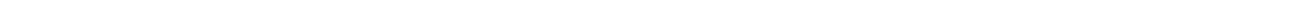
Fig. 2 Ssb is required for proper TORC1-dependent phosphorylation of Sch9-T737. a Cells lacking Ssb display rapamycin sensitivity. Serial dilutions of logarithmically growing cells were spotted onto YPD plates with or without 6 ng ml − 1 rapamycin and were incubated at 30 °C. b Sch9 is hypo- phosphorylated in the absence of Ssb. Protein extracts from glucose-grown Δ sch9 cells expressing Sch9-FLAG were analyzed on phos-tag gels as described in Fig. 1. S3 # indicates the faster migrating species detected in Δ ssb1 Δ ssb2 . c T570 phosphorylation is unaffected by Ssb. Total extracts of the strains indicated were resolved on Tris-Tricine gels and were subsequently analyzed via immunoblotting with α -T570-Pi, α -Sch9, and α -Sse1 (loading control). d Sch9 phosphorylation at T737 depends on Ssb. Protein extracts from Δ sch9 cells expressing Sch9-FLAG or Sch9-T737A-FLAG were analyzed on phos- tag gels as described in Fig. 1. S3 # indicates the faster migrating form of S3 seen in the absence of Ssb, which comigrates with the Sch9-T737A S3 # species. e SNF1-dependent phosphorylation is unaffected by Ssb. Protein extracts from Δ sch9 cells expressing Sch9-5A-FLAG in glucose-rich or glucose-starved (10 min) conditions were analyzed on phos-tag gels as described in Fig. 1. For analysis of the Sch9-5A mutant the concentration of the phos-tag reagent was increased for better resolution (Methods section). f Sch9 is hypo-phosphorylated at T737 in Δ ssb1 Δ ssb2 in the presence or absence of glucose. Glucose-grown Δ sch9 cells expressing Sch9-FLAG (left panel) or Sch9-5A-FLAG (right panel) were depleted for glucose for the indicated times and were analyzed on phos-tag gels as described in Fig. 1. Sch9 species, which migrated faster in Δ ssb1 Δ ssb2 cells when compared to the wild type are indicated with # . g Cartoon summary of Sch9 phosphorylation in Δ ssb1 Δ ssb2 cells. In glucose-rich conditions Sch9 is distributed between S0, S1, and S3 # in Δ ssb1 Δ ssb2 . When compared to S3 (Fig. 1f) S3 # lacks the phosphorylation at residue T737. In glucose-starved conditions Sch9 is distributed between S2 #